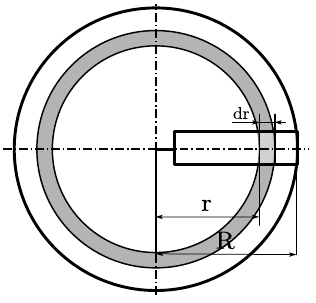
Figure 2. The circular element in the momentum ‐ element model.